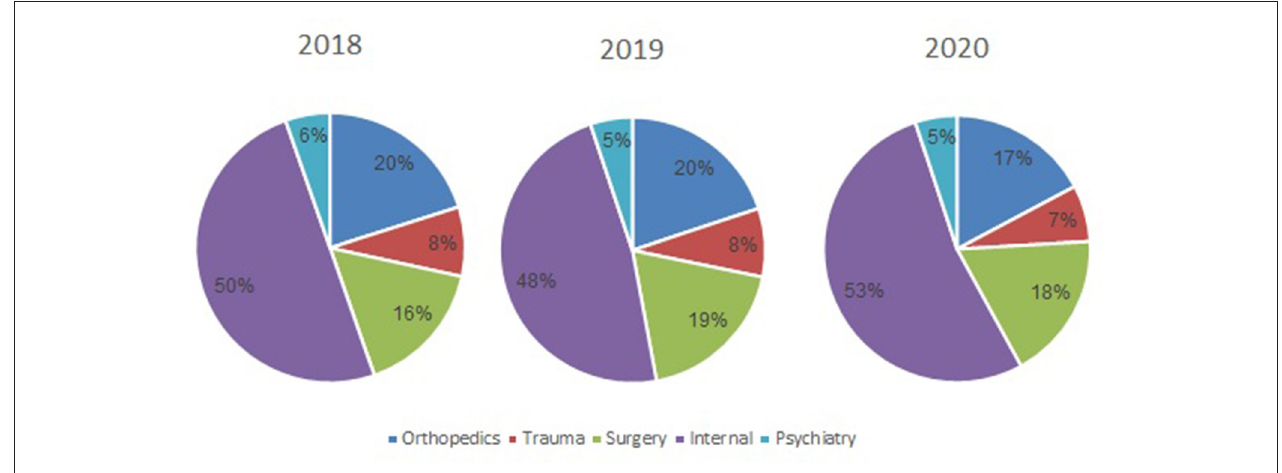
FIGURE 1 | The proportion of psychiatric consultations of the total number of visits to the emergency department, by year.